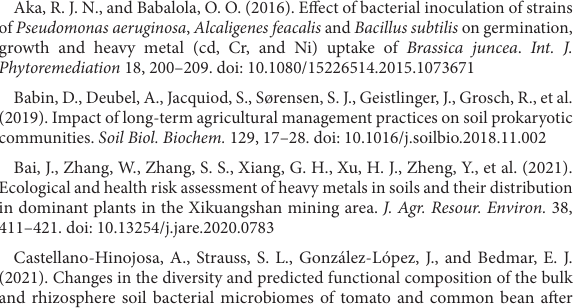
SUPPLEMENTARY FIGURE S1 Site location of the study area. SUPPLEMENTARY FIGURE S2 The seed network of dominant bacterial